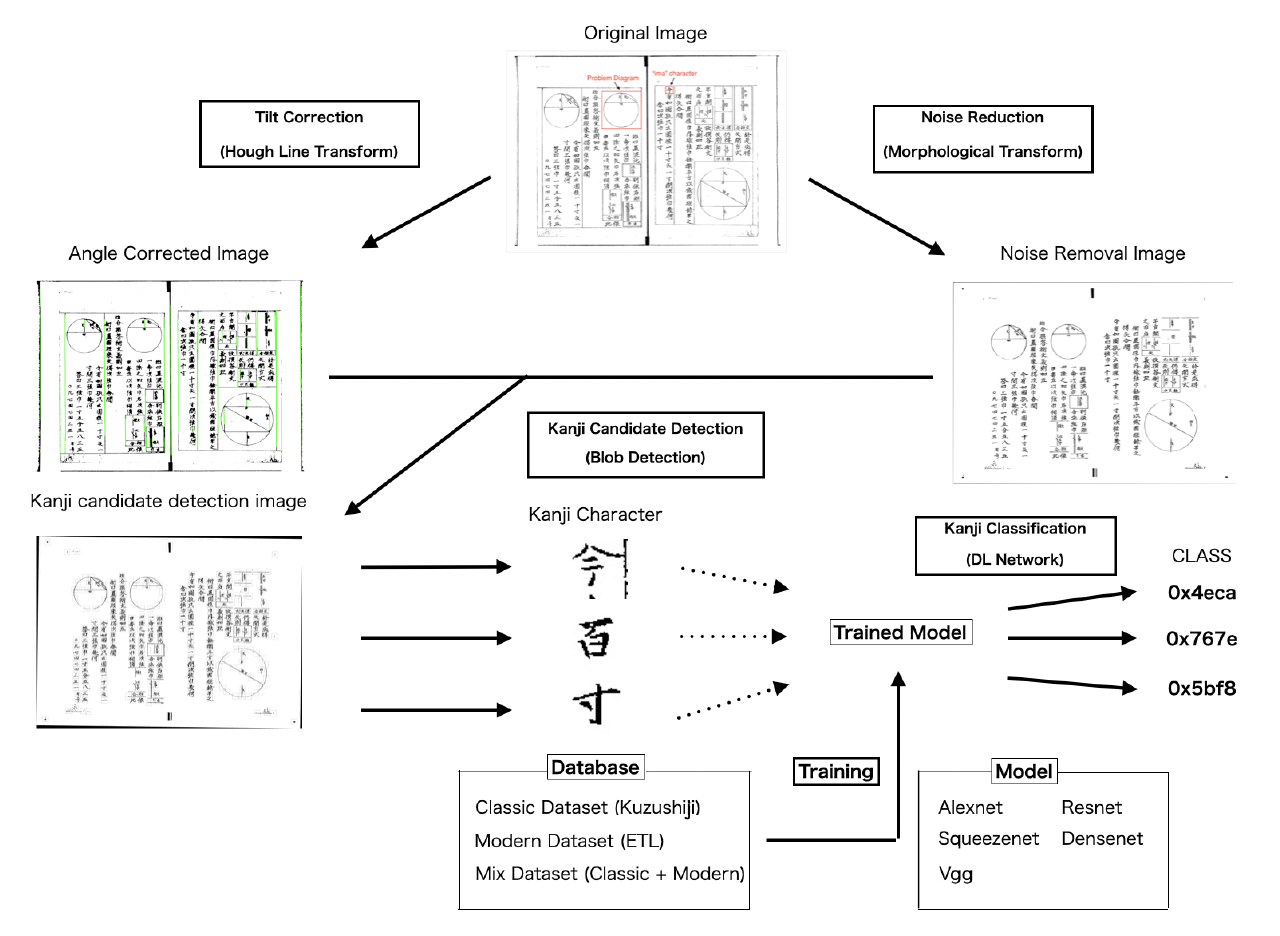
Figure 4. Image Processing